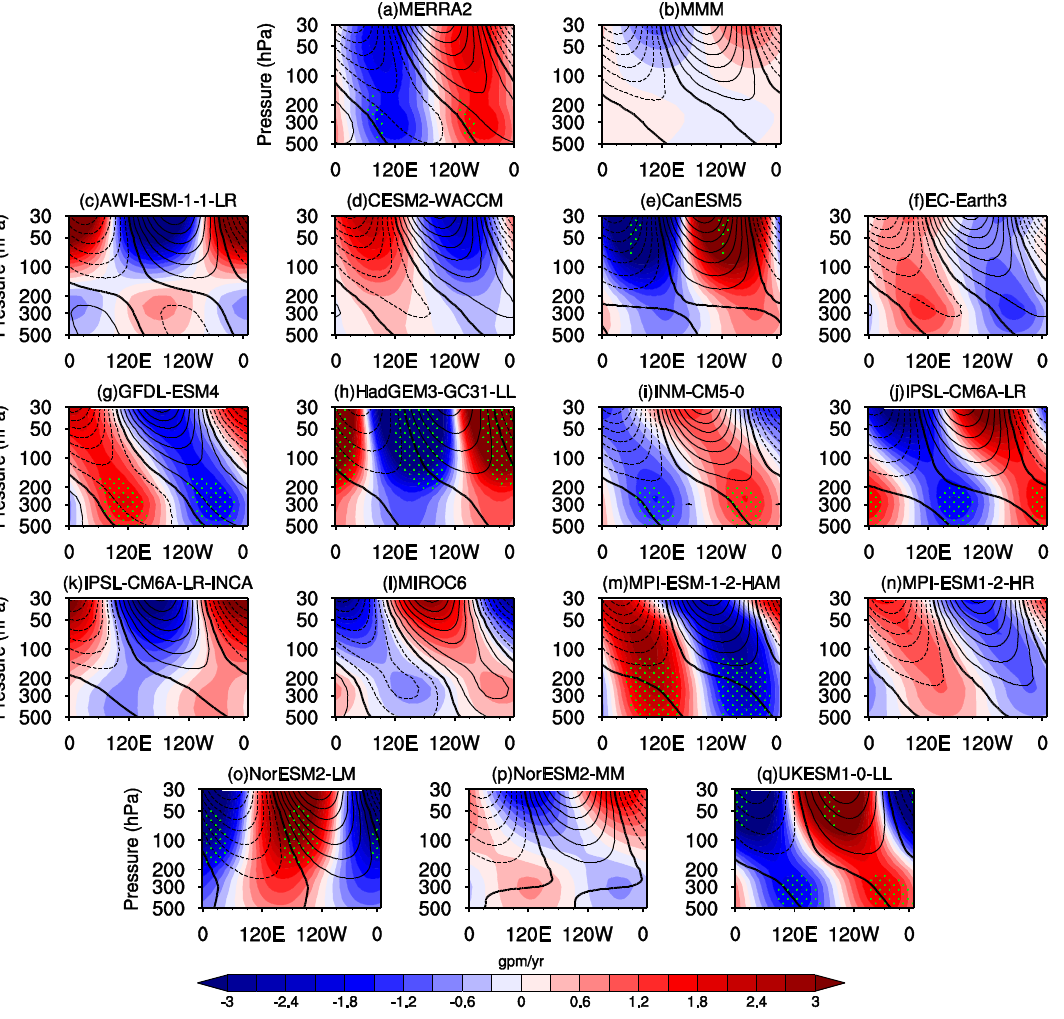
Figure 10. Height-longitude cross sections along 60 ◦ N of zonal wave-1 geopotential height trend over the period 1981–2014 (shaded areas). Black contours indicate climatological mean of zonal wave-1 geopotential height along 60 ◦ N for the period 1981–2014 in February derived from ( a ) MERRA2, ( b ) multi-model mean and ( c – q ) individual CMIP6 model simulations. Green dotted regions are for values statistically significant at the 90% confidence level by Student’s t -test.